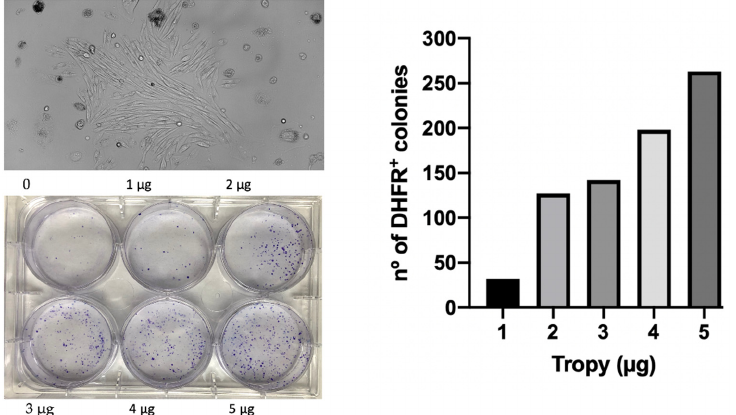
Figure 8. The efficiency of plasmid transfection using TROPY. The pDCH1P plasmid (300 ng) was transfected with the indicated amounts of TROPY in 1 mL of full F12 medium in 35 mm diameter dishes. After 30 h, the medium was replaced with DHFR selective medium lacking hypoxanthine and thymidine. A microscope view of a representative colony after metabolic selection is shown. Colonies were stained with crystal violet and counted.